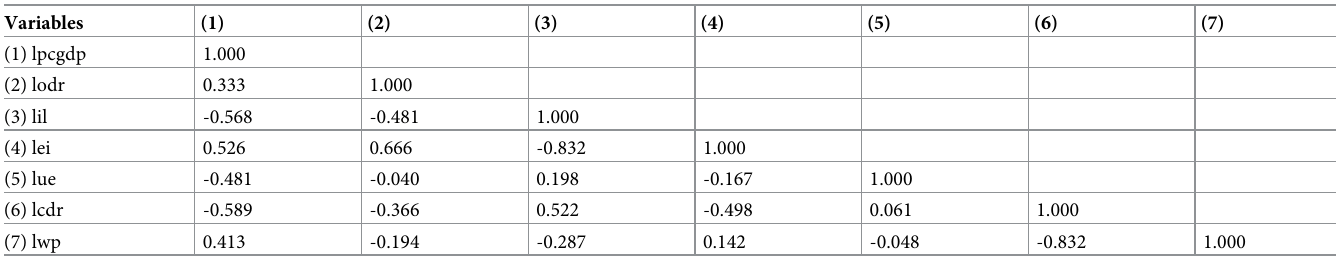
Table 8. Pairwise correlation of western region of China.